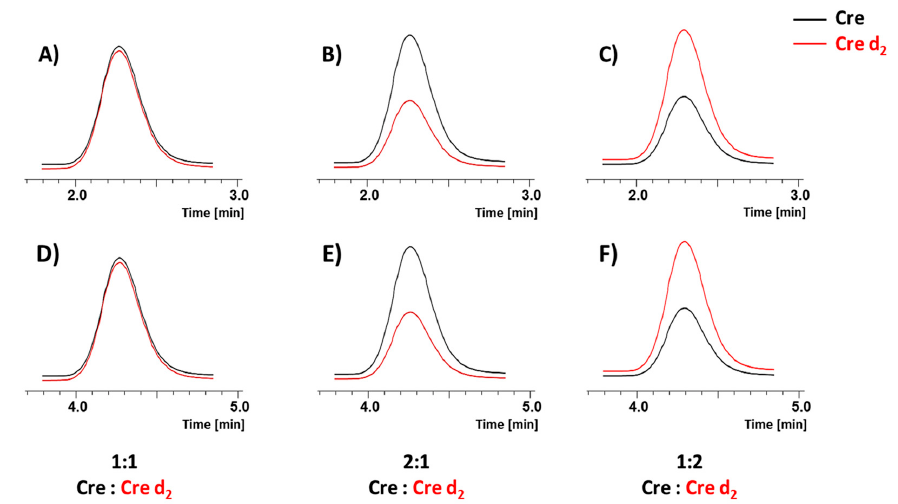
Figure 3. Extracted ion chromatograms of non-deuterated ( Cre , black line) and deuterated ( Cre d 2 , red line) creatinine samples obtained on the ( A – C ) C18 and ( D – F ) HILIC Luna column, mixed in different ratios: ( A , D ) 1:1; ( B , E ) 2:1 and ( C , F ) 1:2. The signal intensities correspond to the amount of isotopologues present in the analyzed samples.